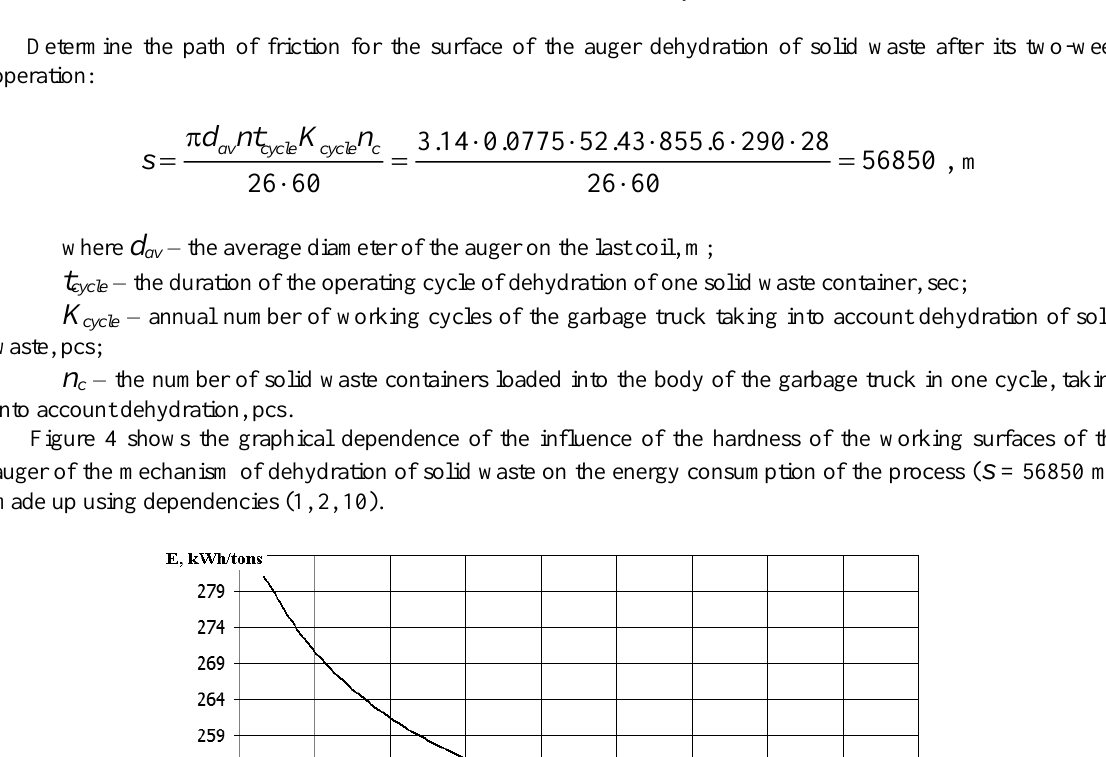
Fig. 3. The dependence of the wear of the auger u in the plane of the parameters of influence: the hardness of its surface H and the friction path s